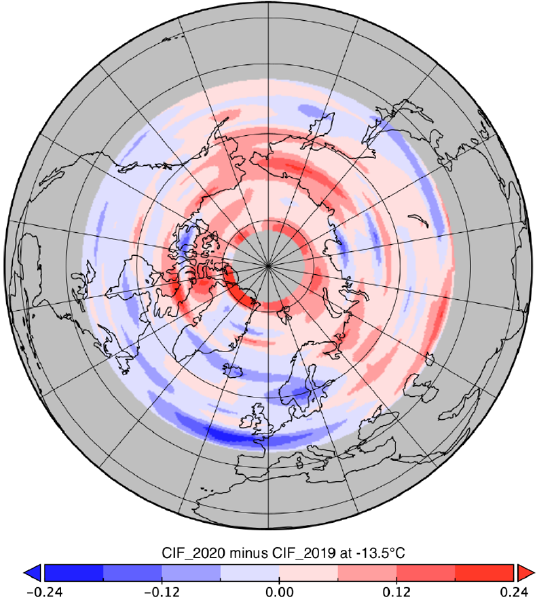
Figure 13. CIF during April 2020 minus CIF during April 2019 at a cloud top temperature of − 13.5 ◦ C (only data above 45 ◦ N are